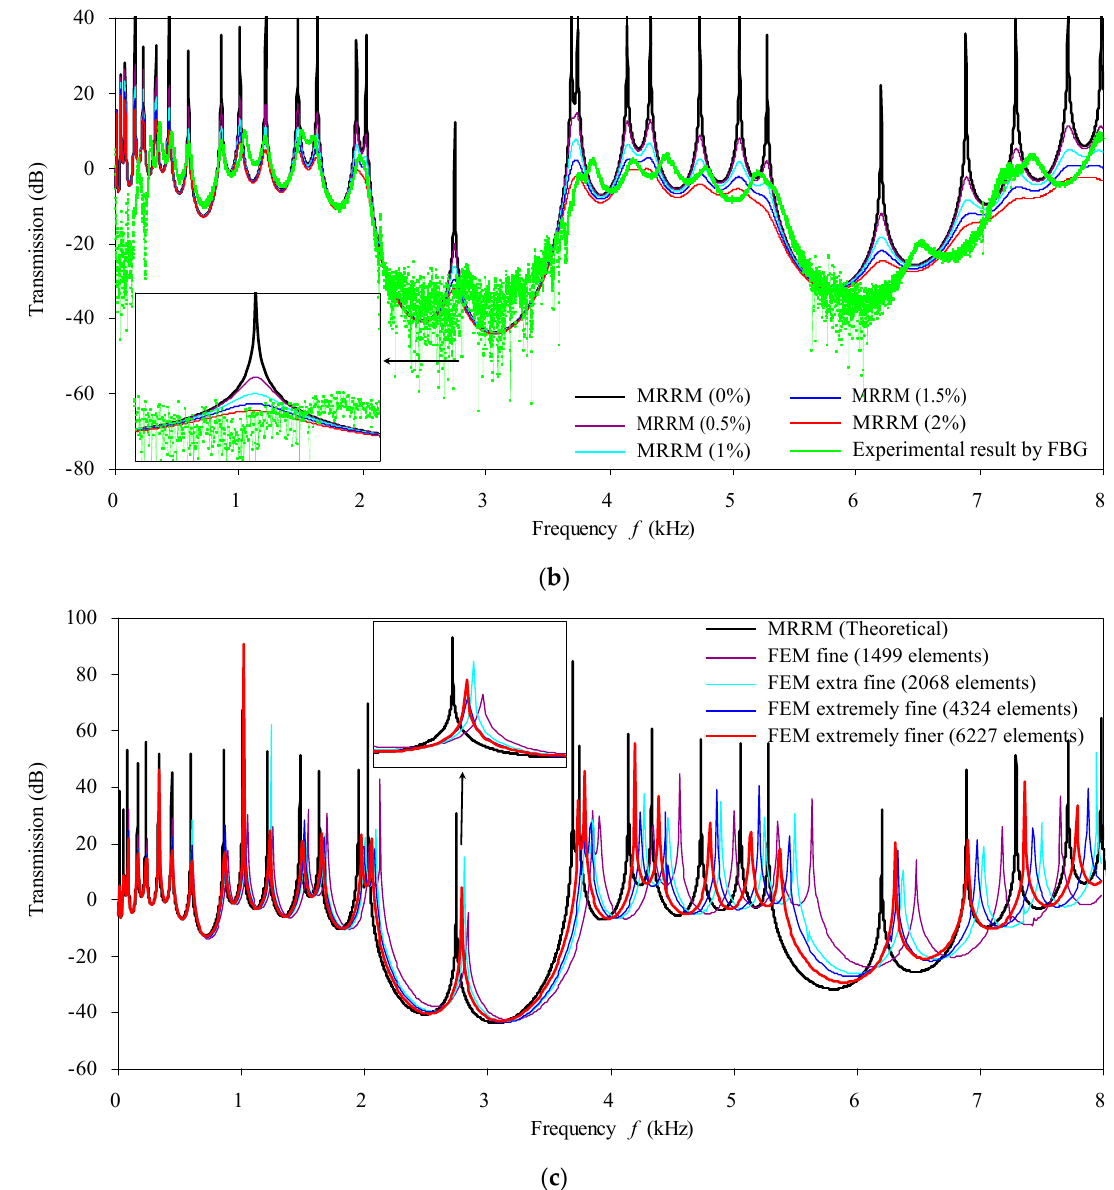
Figure 6. The transmission (dB) spectra of deflections at two ends of the defected phononic crystal beam in Figure 5: ( a ) Results obtained by the MRRM with 1% damping ratios, by the experiment and by the FEM with 1% isotropic structural loss factors and with 6227 elements; ( b ) Results obtained by the MRRM with five cases of damping ratios and their comparisons with the experiment result; ( c ) Undamped results obtained by the FEM with four meshing schemes and their comparisons with the MRRM result.